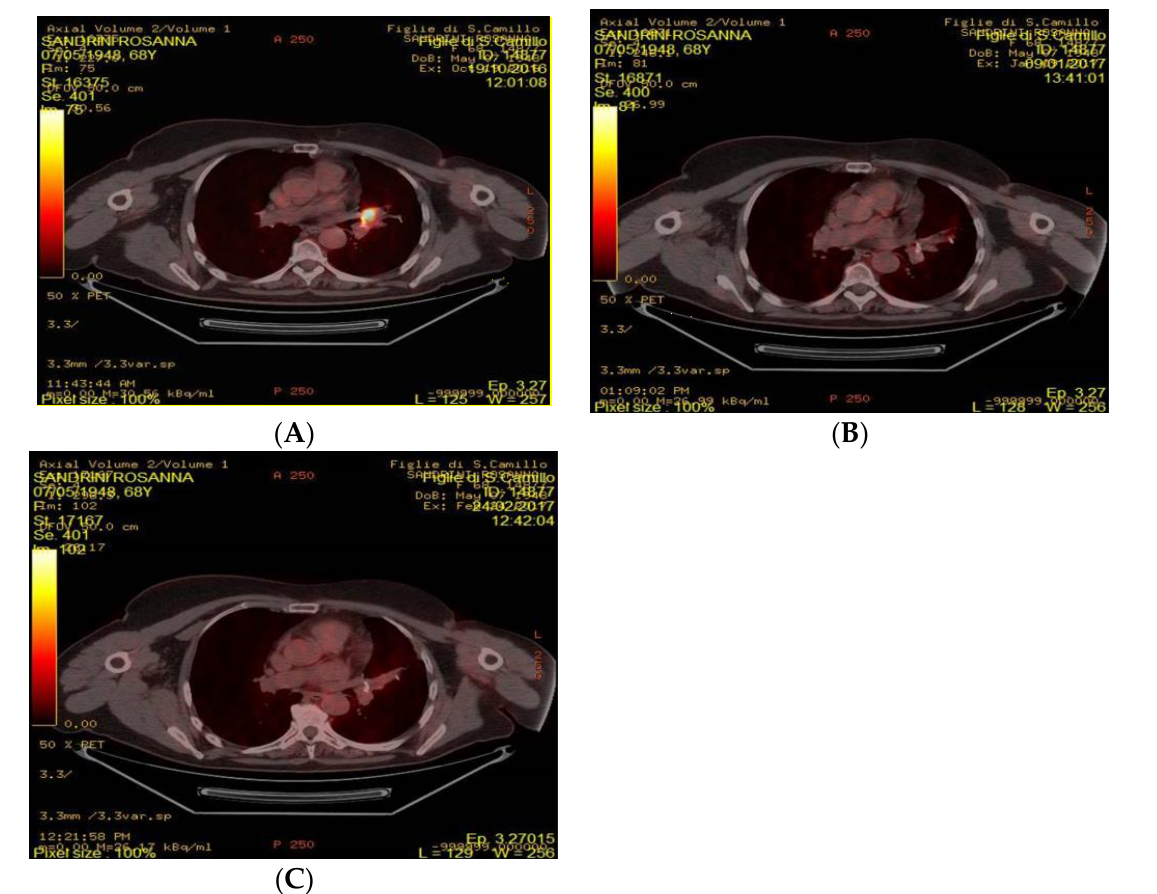
Figure 3. Kaplan–Meier survival estimates based on differences in metabolic response at three months. ( A ) Progression Free Survival in non-LRs ( B ) Overall survival in non-LSs.